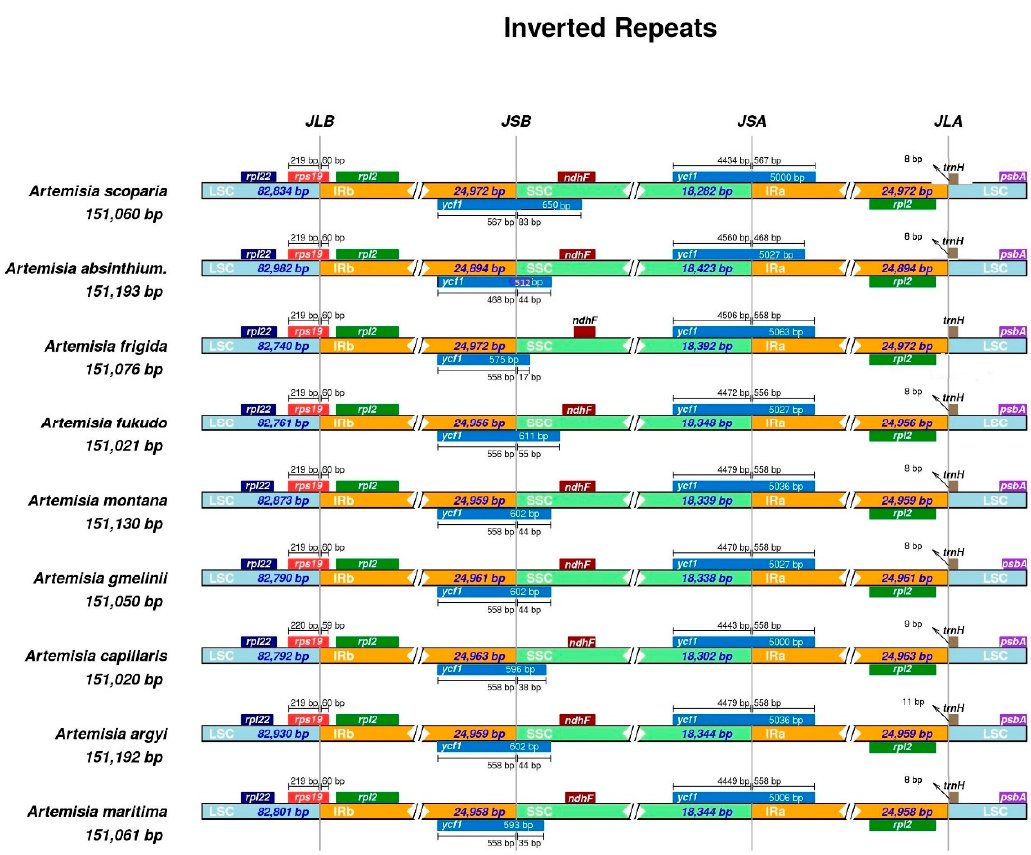
Figure 2. Details of the contraction and expansion of inverted repeats at junction sites. For all plant species, positive strand genes are represented at the top, from right to left, on the corresponding track, whereas negative strand genes are illustrated on the lower side of the track, from left to right. Arrows depict the distance between the start and end of a gene from the junction site. Scale bar present above or below the genes extending from one region to another illustrates the number of base pairs to which genes join in that region. JSA (SSC / IRa), JSB (IRb / SSC), JLA (IRa / LSC), and JLB (IRb / LSC) indicate the junction sites between two corresponding regions of a genome. The plotted genes and distances surrounding the junction site are a scaled projection of the genome.